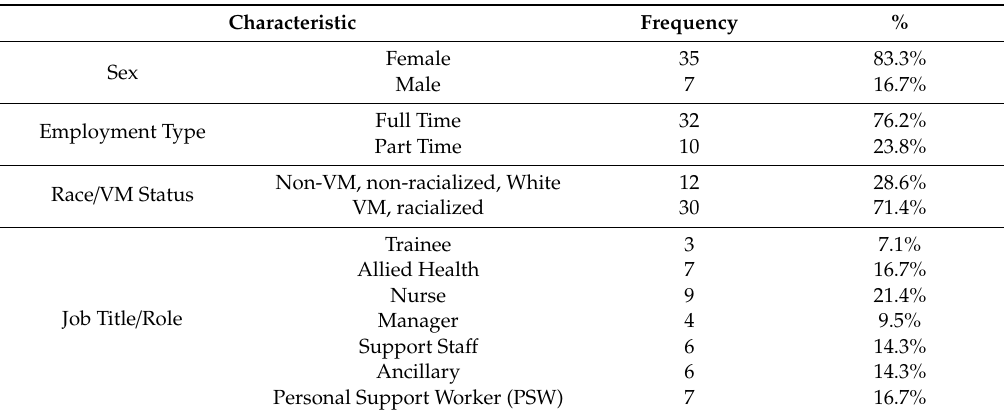
Table 1. Interview participants’ characteristics ( n = 42).